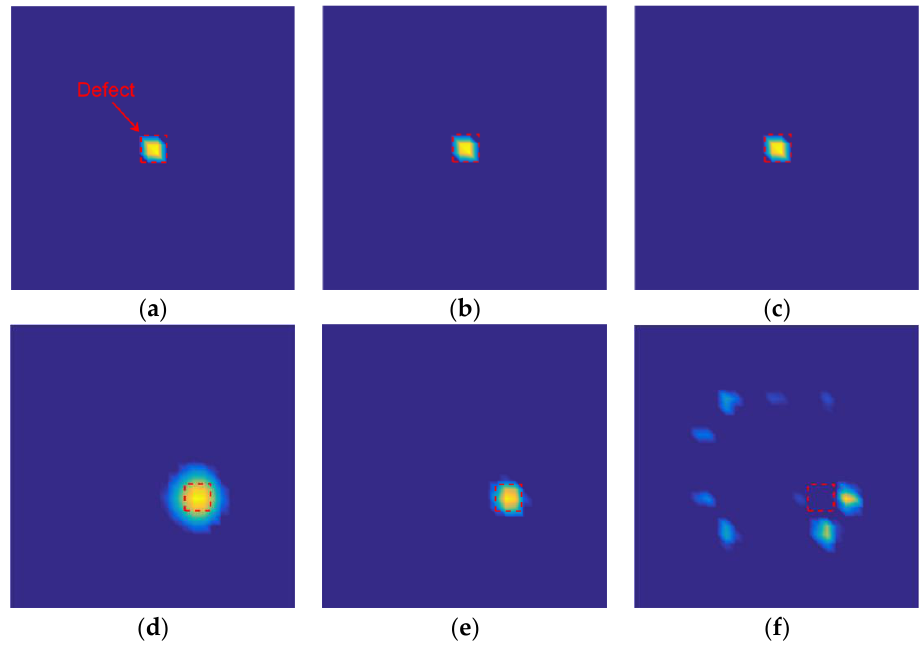
Figure 10. Reconstructed images after data reduction, sample 1 ( a ) 66-measurement capacitance data image reconstruction result, ( b ) 29-measurement capacitance data image reconstruction result, ( c ) 17-measurement capacitance data image reconstruction result, sample 2 ( d ) 66-measurement capacitance data image reconstruction result, ( e ) 29-measurement capacitance data image reconstruction result, and ( f ) 17-measurement capacitance data image reconstruction result.